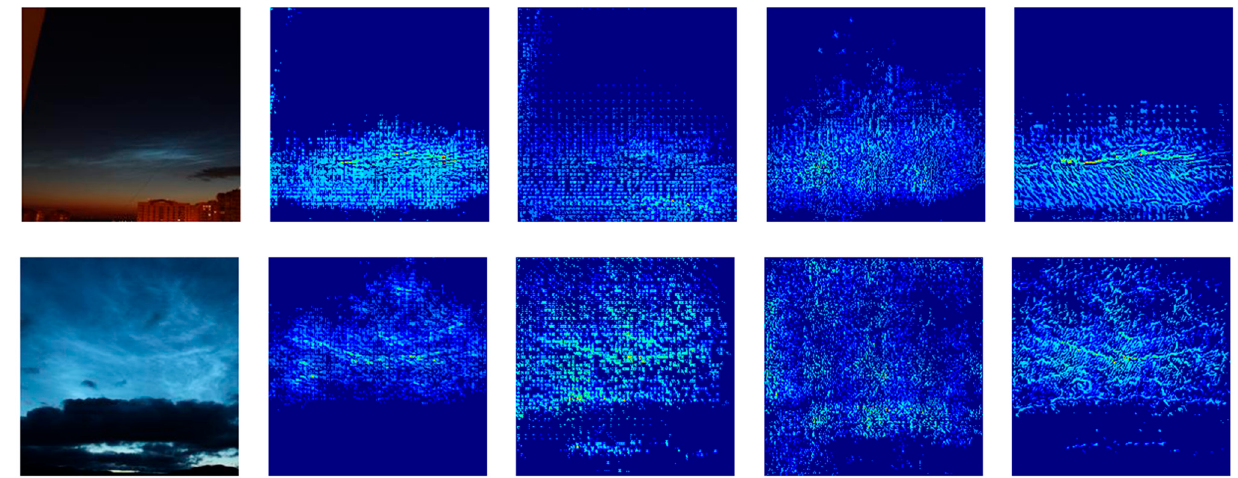
Figure 4. Test images and their saliency map for NLC class.